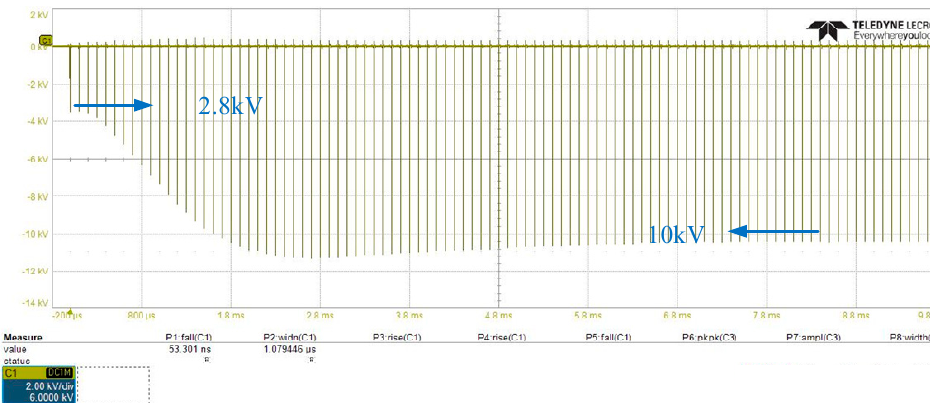
Figure 10. Output voltage dynamic response during starting.